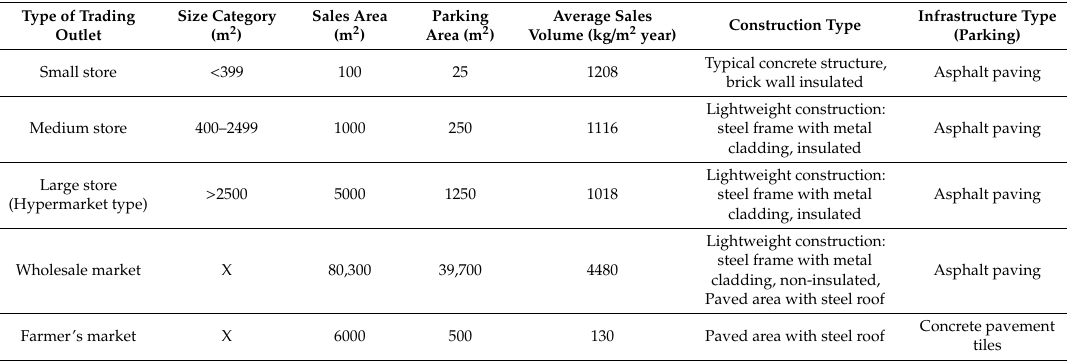
Table 6. Definition of trading